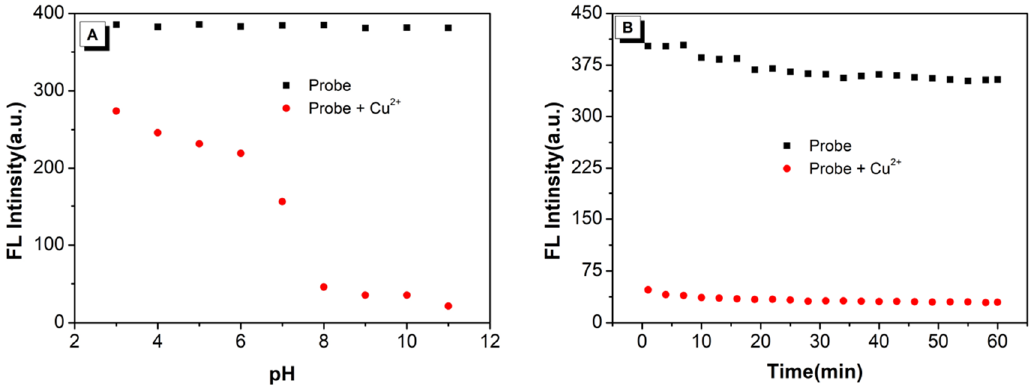
Figure 2. The fluorescence intensity stability of the L and L- Cu 2+ systems versus different ( A ) pH values and ( B ) reaction time.